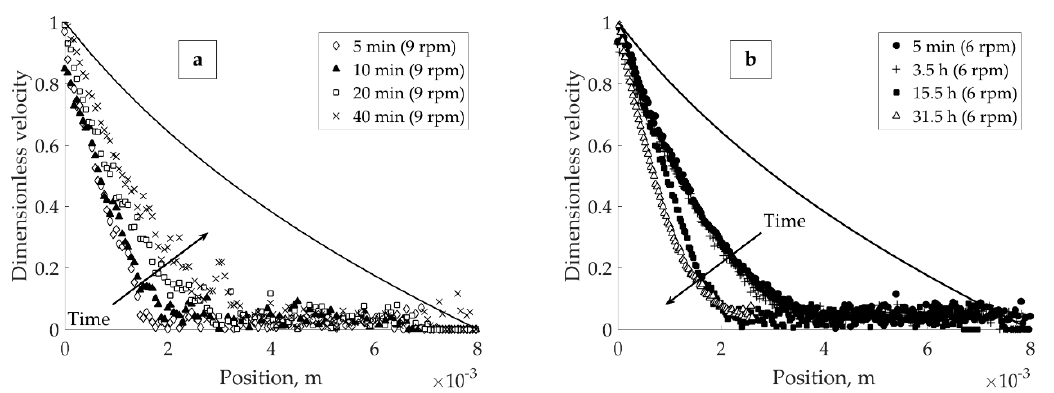
Figure 7. Velocity profiles of pH 4 in 1 × 10 − 2 M NaCl bentonite suspension: ( a ) Achievement of a steady localized profile after loss of banding at 9 rpm; ( b ) Recovery of the localized profile under the load, after agitation at 27 rpm.